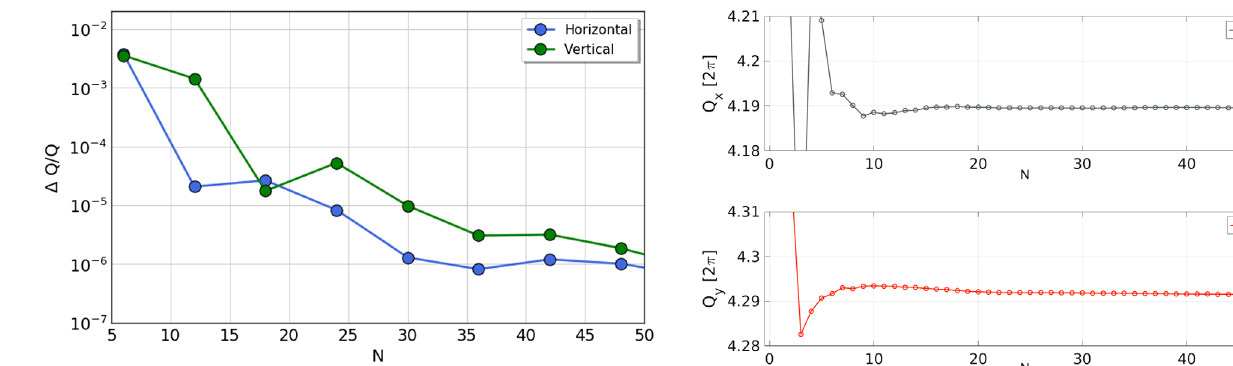
FIG. 16. The absolute difference between the tune measure- ments by mixing ten regular and ten irregular BPMs, normalized to the tunes for the ten mixed regular BPMs, with respect to the first 50 turns. The horizontal tune is shown in blue and the vertical in green. The vertical axis is in the logarithmic scale.